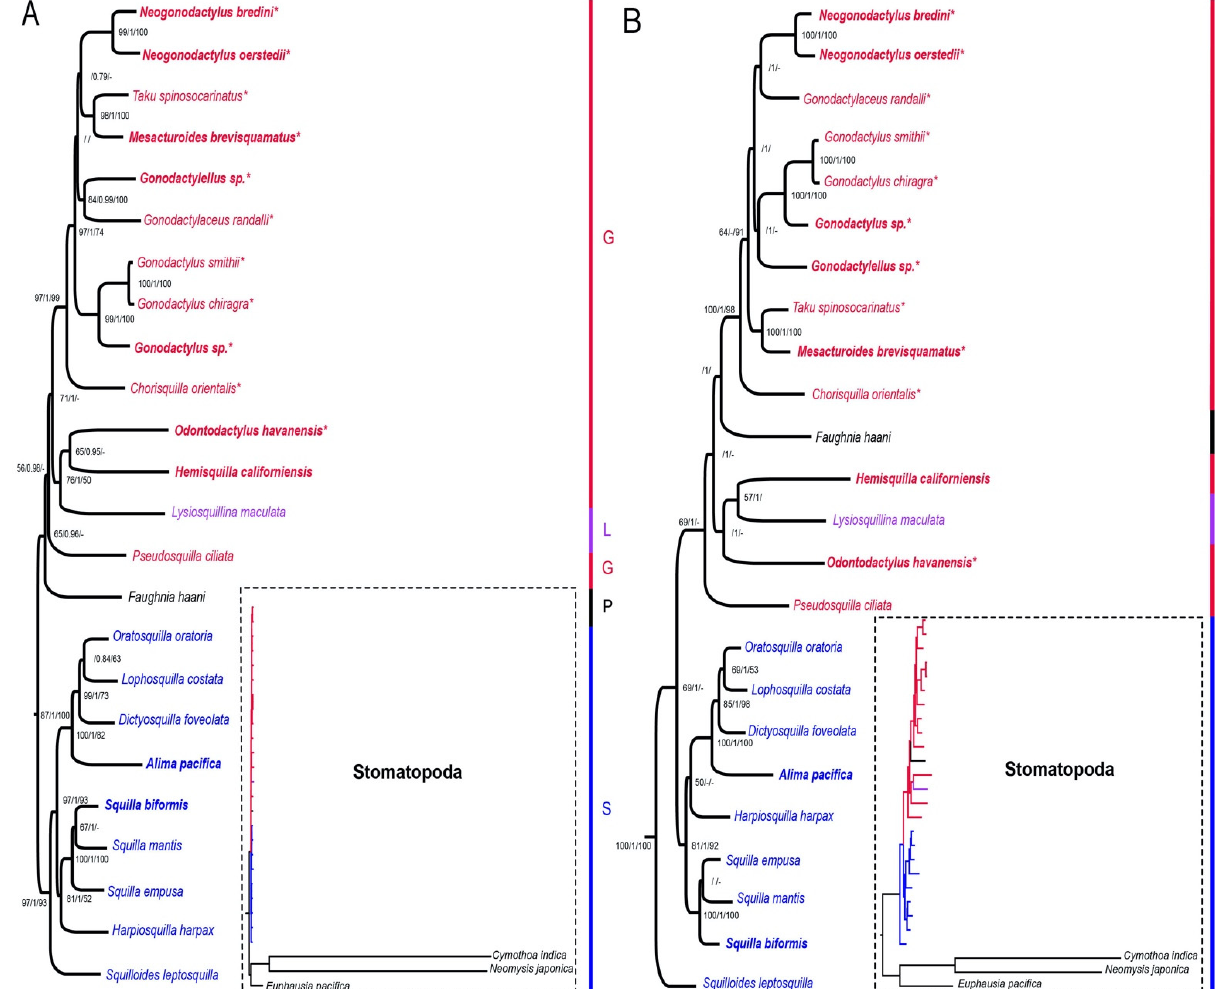
Figure 3. Stomatopoda phylogeny based on the concatenated mitochondrial genes and 18S rRNA sequences; rooted with Euphausia pacifica, Cymothoa indica , and Neomysis japonica (not shown in main figures, they are indicated in the dotted boxes). Newly sequenced taxa are in bold. Each superfamily is coded by the color of the taxon name. Superfamily abbreviations are G: Gonodactyloidea, L: Lysiosquilloidea, S: Squilloidea, P: Parasquilloidea. Asterisks (*) after the taxon name denote smashers. Values at the nodes represent the bootstrap values of ML and MP and the posterior probability of BI in the format (ML/BI/MP). Values not listed were below 50 for bootstrap or below 0.70 for posterior probabilities. Hyphens (-) represent nodes not recovered by the MP or BI analyses. Branch lengths relative to the outgroups are shown in the dotted boxes to the right of each main figure. ( A ) Maximum likelihood tree from the nucleotide dataset (EumalNuc). ( B ) Maximum likelihood tree from the mixed amino acid and nucleotide dataset (EumalAA).